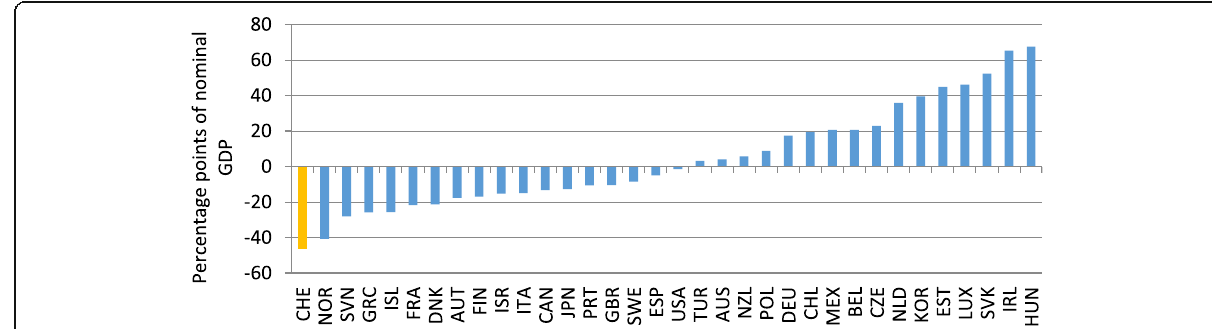
Fig. 8 Comparison of estimated and actual trade openness using the inverse of the squared distance between grid cells as weighting scheme for economic activity. Year: 2012, Source: Authors ’ calculation based on information by SECO